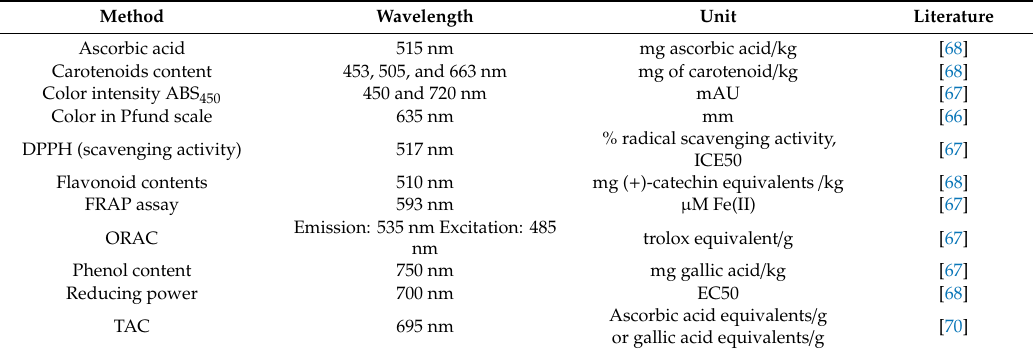
Table 4. Selected methods of assessing the antioxidant properties of